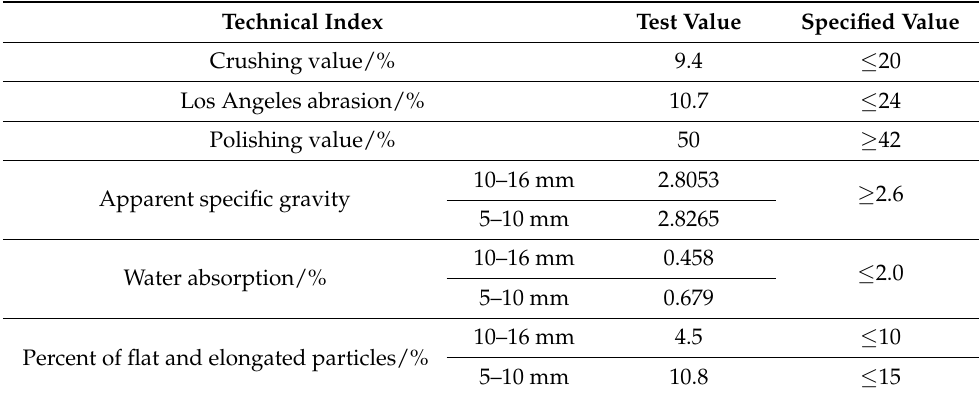
Table 4. Basic technical indexes of coarse aggregate [13].